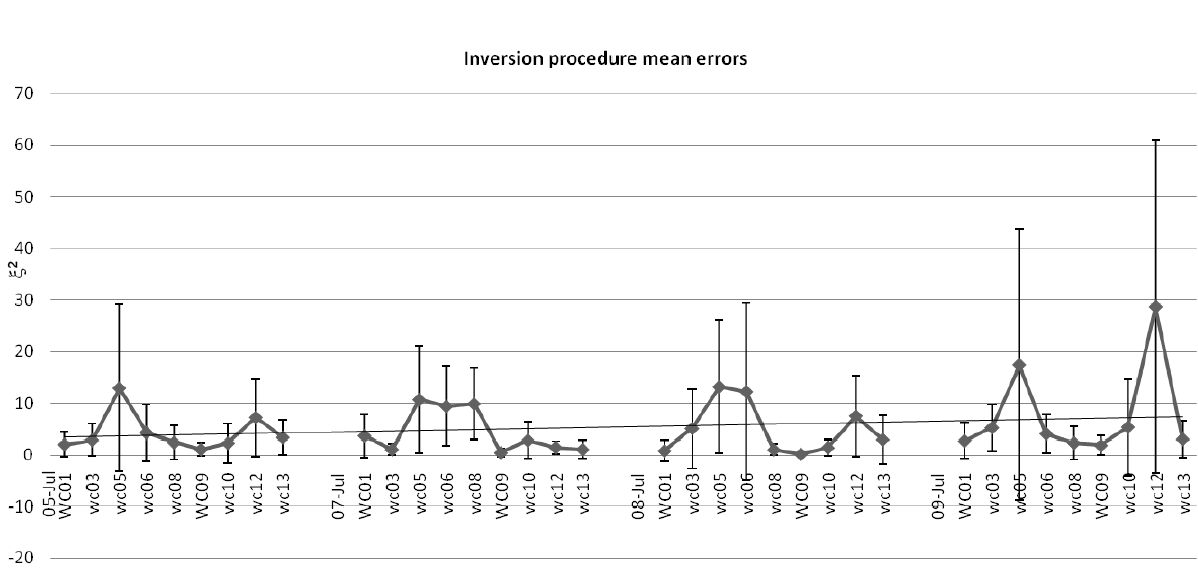
Figure 3 . The error variability 2 ξ for each field and for each analyzed date. The errors have t been averaged on all inversion algorithms. The error bars are ±1.0 standard deviation with